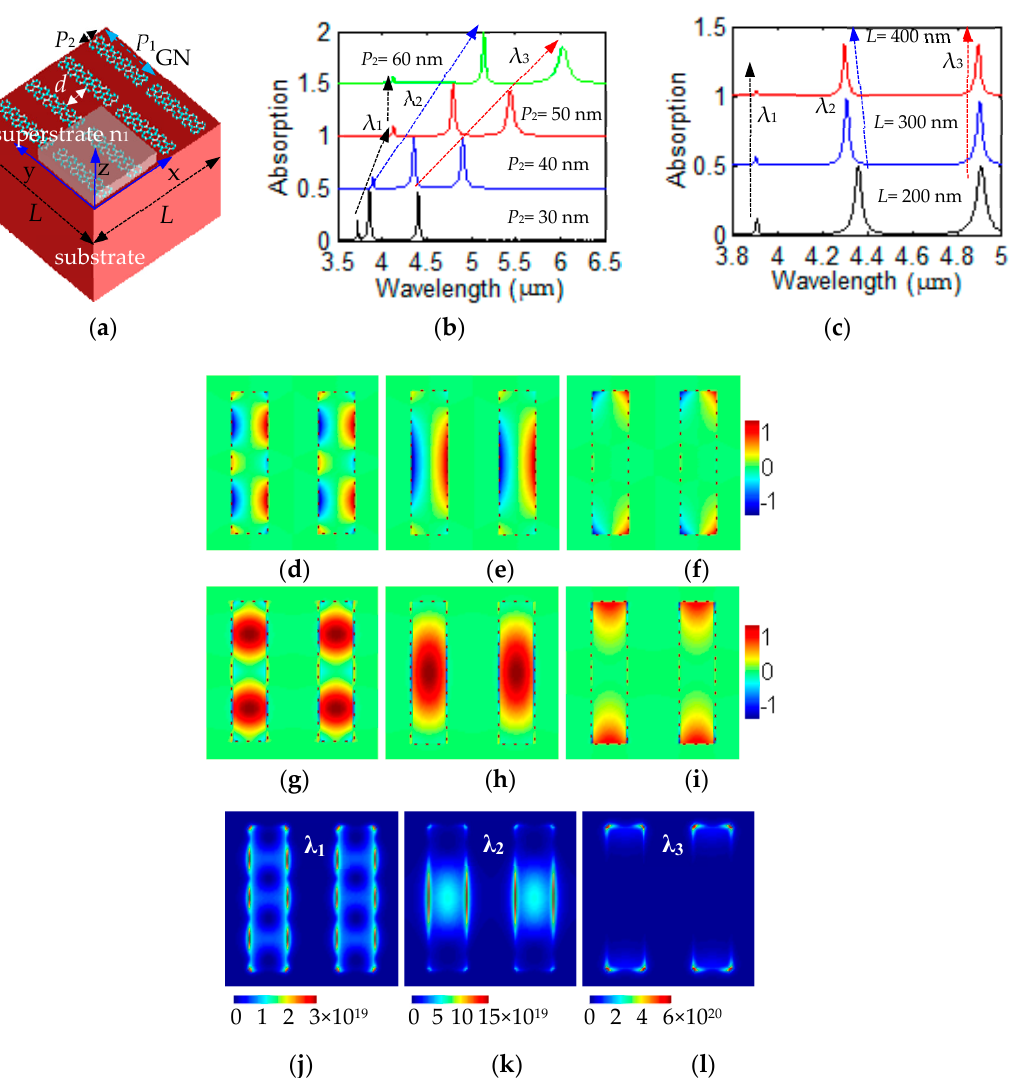
Figure 1. ( a ) The nanostructured GN surrounded with substrate and superstrate. ( b ) The absorption with different width P 2 = 30 nm, 40 nm, 50 nm and 60 nm, respectively. ( c ) The absorption with different lattice period L = 200 nm, 300 nm and 400 nm, respectively. The distributions of electric field E z at ( d ) λ 1 = 3.9 μ m, ( e ) λ 2 = 4.35 μ m, and ( f ) λ 3 = 4.90 μ m, respectively. The distributions of electric field E x at ( g ) λ 1 = 3.9 μ m, ( h ) λ 2 = 4.35 μ m, and ( i ) λ 3 = 4.90 μ m, respectively. The distributions of photon flux density Φ at ( j ) λ 1 = 3.9 μ m, ( k ) λ 2 = 4.35 μ m, and ( l ) λ 3 = 4.90 μ m, respectively.